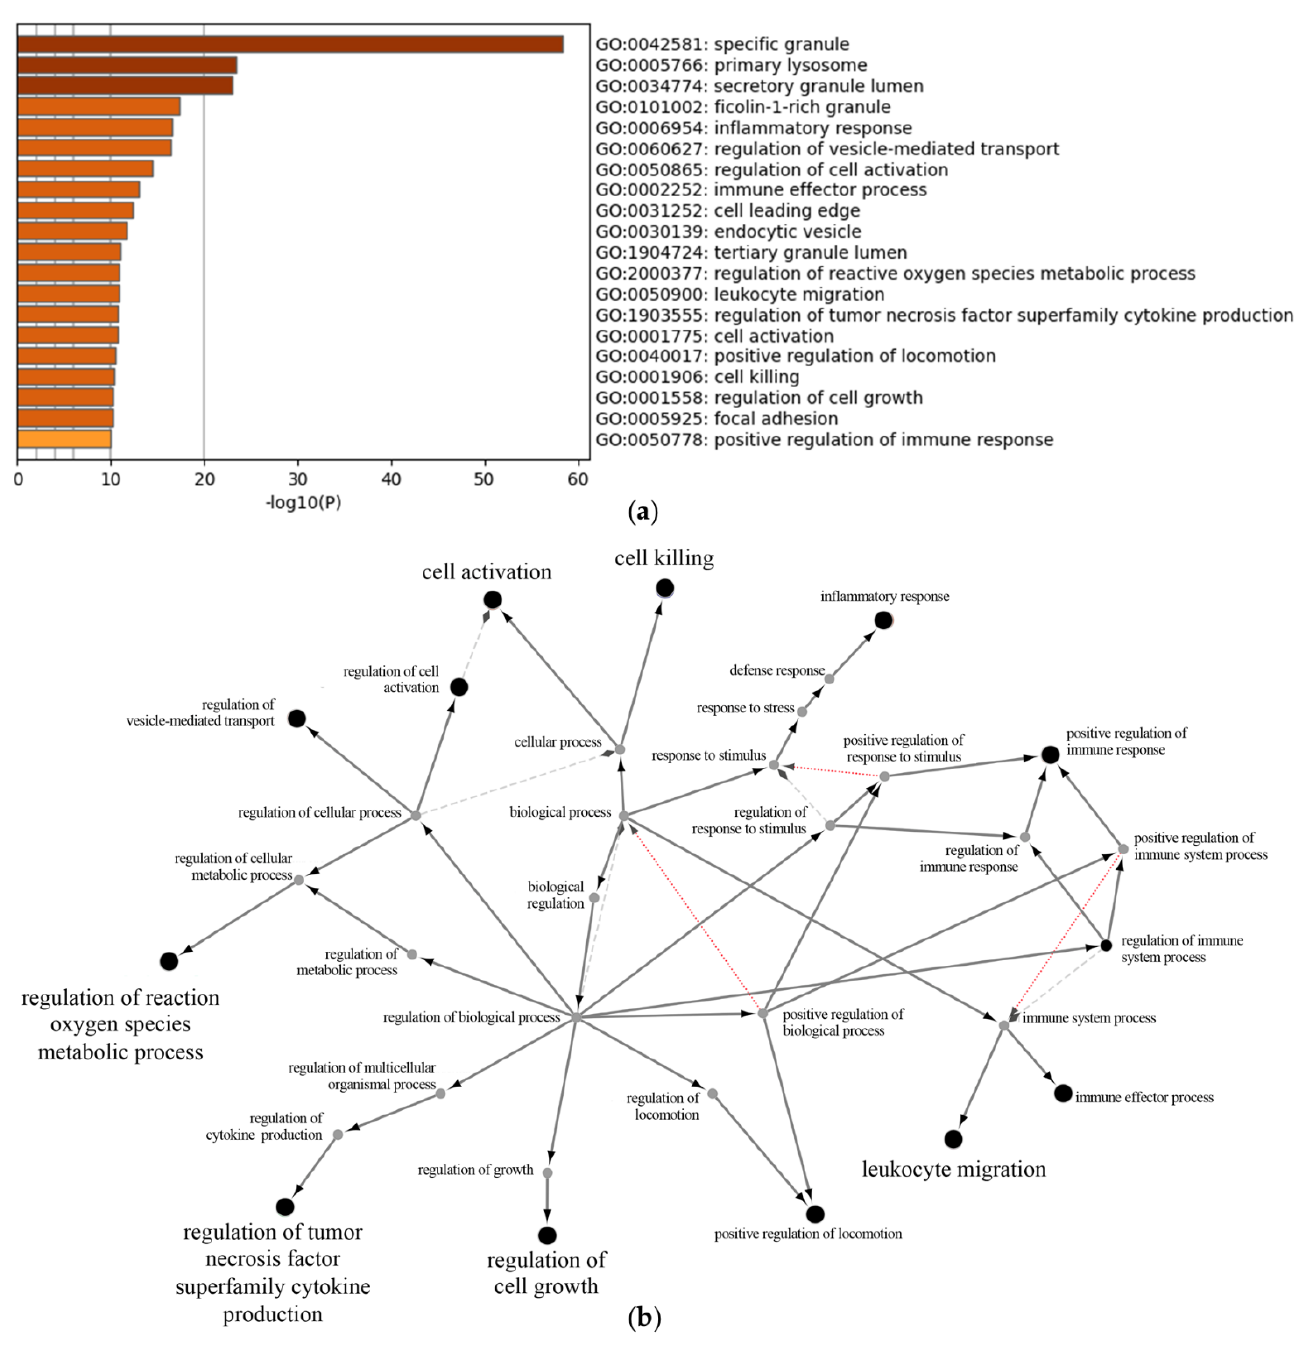
Figure 5. Gene ontology enrichment analysis of proteins upregulated by LPS in neutrophil-derived EVs. Enrichment clusters identified by Metascape ( a ) and functional analysis of enriched GO terms from the parent node to the root node, illustrated with ClueGo and Cluepedia in Cytoscape ( b ).